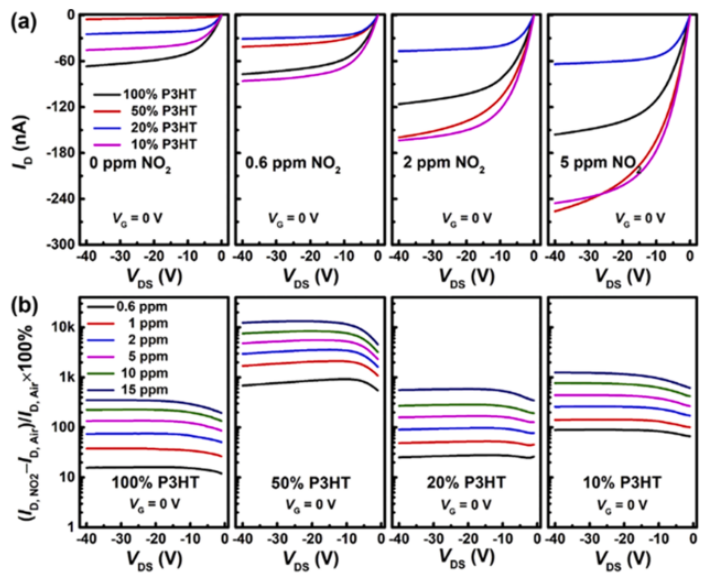
Figure 7. Variations of I D and µ of the indicated P3HT mass fractions at the given NO 2 concentrations with different carrier gases. Reprinted with permission from Ref. [76]. Copyright 2018, Yang, Z. et